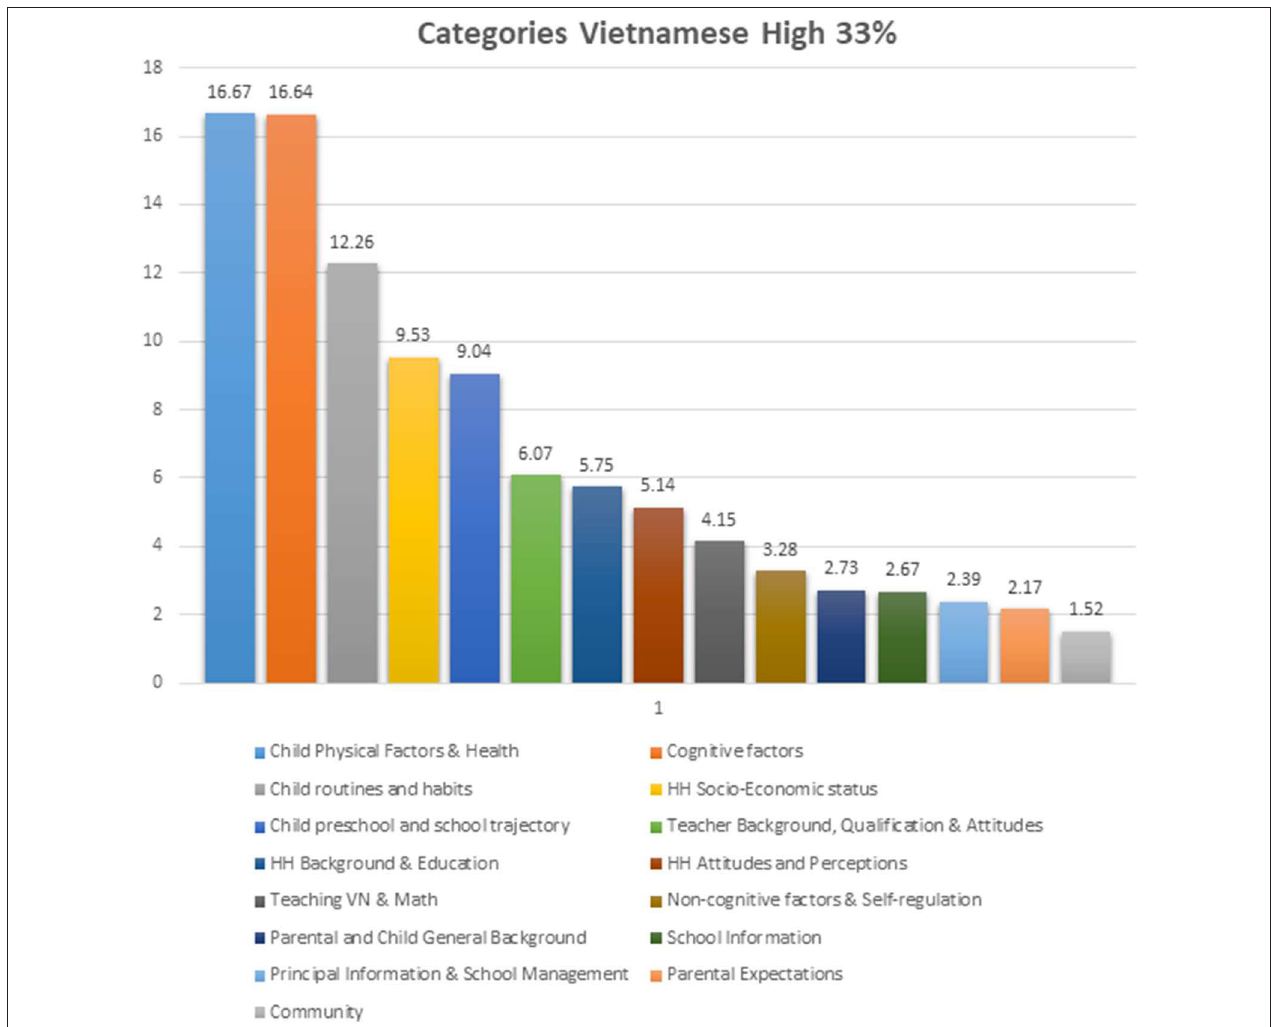
FIGURE 5 | Comparative observed predictive weight contribution for the high 33% of vietnamese performance by each of the categories of predictor